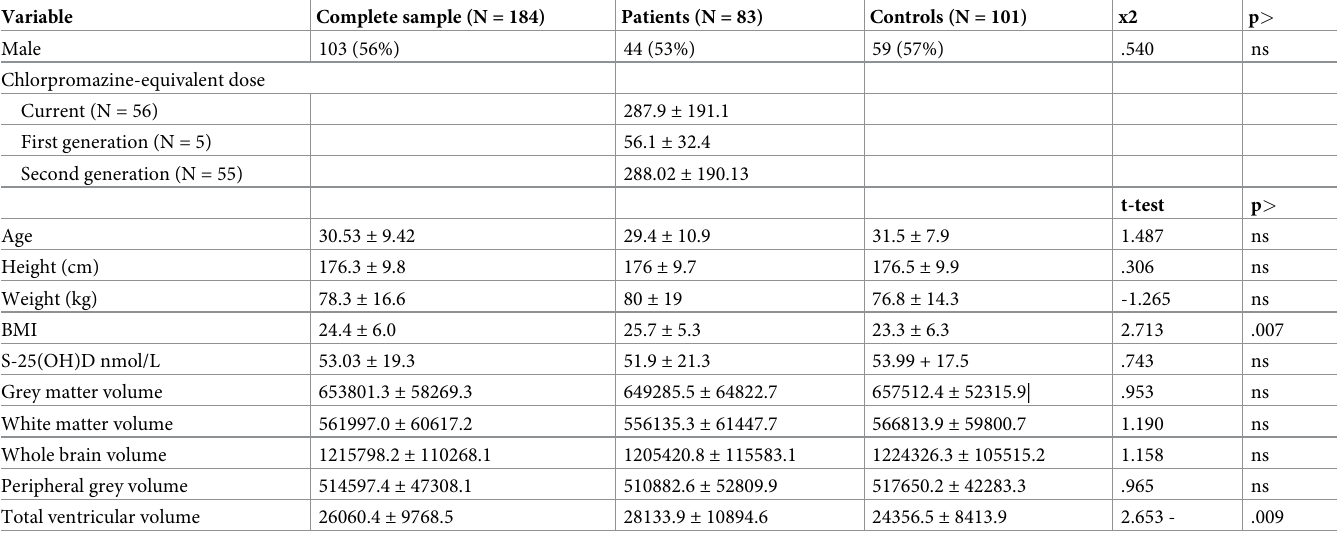
Table 3 shows correlations between S-25(OH)D and normalized whole brain, white matter, grey matter, peripheral grey matter volume and total ventricular volume before adjustment for age, gender and height. There were no significant associations for the analyses of the whole sample. Stratifying for patient versus control revealed that S-25(OH)D levels correlated posi- tively with white matter (p < .02), whole brain (p < .02) and peripheral grey matter (p < .05) volumes in the patient group but not in the controls. We found no significant associations between level of medication use (measured as CPZ equivalents) and neither S-25(OH)D levels nor measures of brain volume, the exception being a negative correlation between CPZ for first generation anti-psychotics and grey matter vol- ume (r = -.885, p < .05) (data not shown). This measure was, however, based on the only 5 par- ticipants currently on first generation anti-psychotic medication, and therefore not controlled for in further analyses. The results for associations between S-25(OH)D levels and genotypes can be found in Table 4. S-25(OH)D levels were significantly associated with SNPs rs2282679 and rs7041 . Posi- tive correlations were found between the rs1544410 marker with white matter (r = .206, p < .01) and whole brain volume (r = .159, p < .05), and the rs6013897 marker and total ventricular Table 2. Sample description and patient/healthy control comparison.